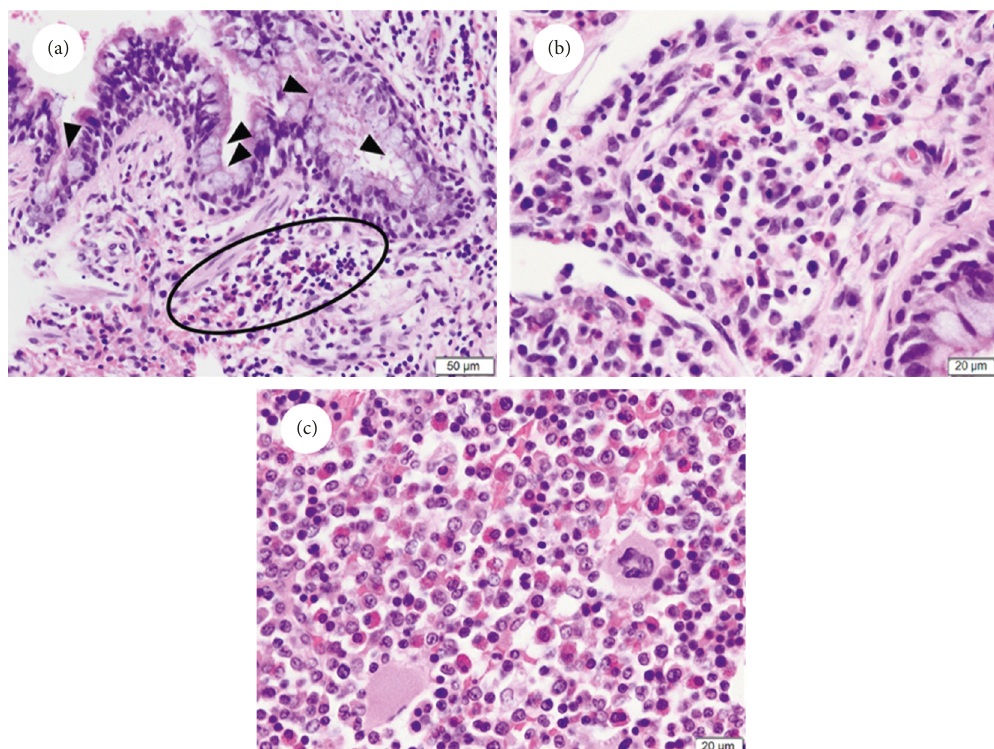
Figure 3: Histology of the lungs and bone marrow. (a) Hematoxylin and eosin- (H&E-) stained figure of the lungs ( × 200). Goblet cell metaplasia of the epithelium (arrowheads) and eosinophilic infiltration (ellipse) in the airway wall. (b) Higher magnification ( × 400) of subfigure (a). Infiltration of eosinophilic cells is observed. (c) H&E-stained figure of the bone marrow ( × 400). Marked increased eosinophil number is observed. Scale bars � 50 μ m (a) and 20 μ m (b and